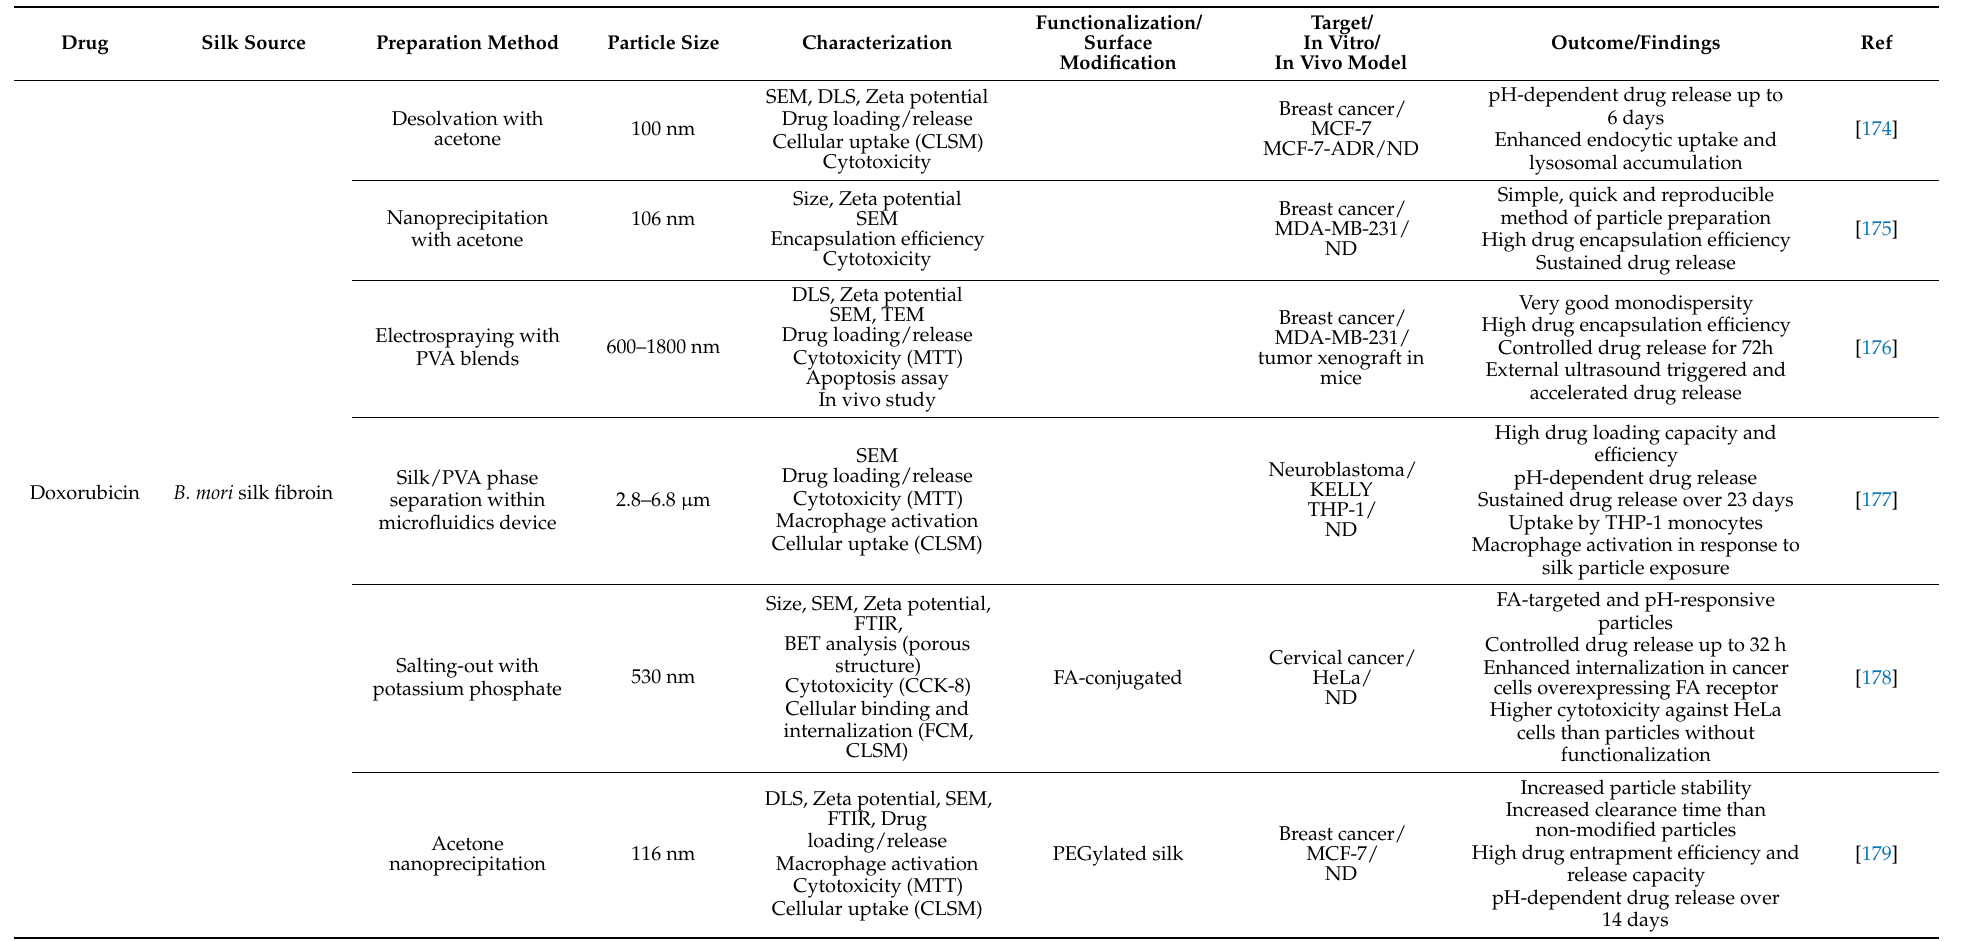
Table 2. Delivery of chemotherapeutics using silk-based